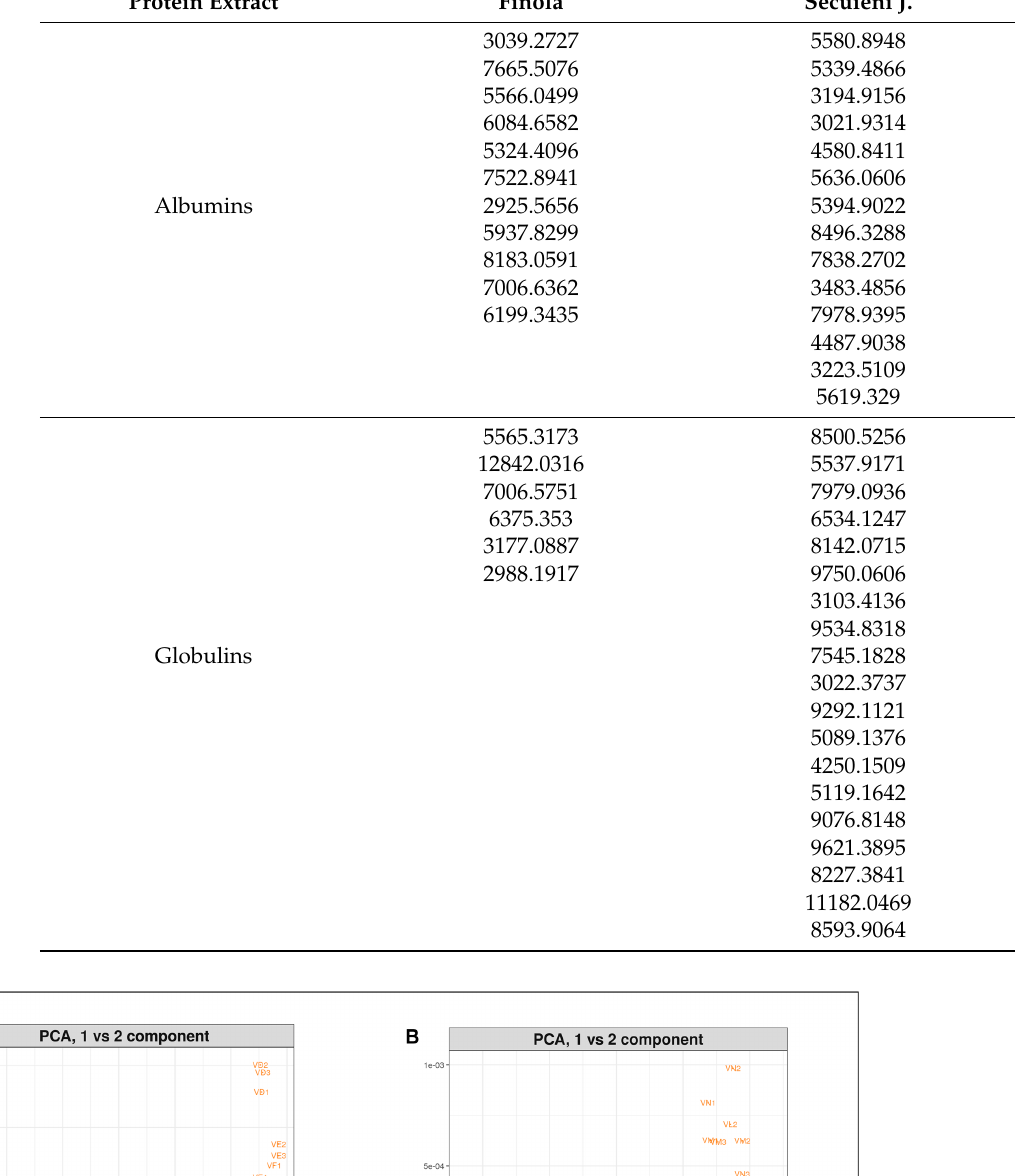
Table 4. Mass signals from albumin and globulin extracts of certified seeds corresponding to the top 25 loadings on PC1 and their correlation with plant variety.